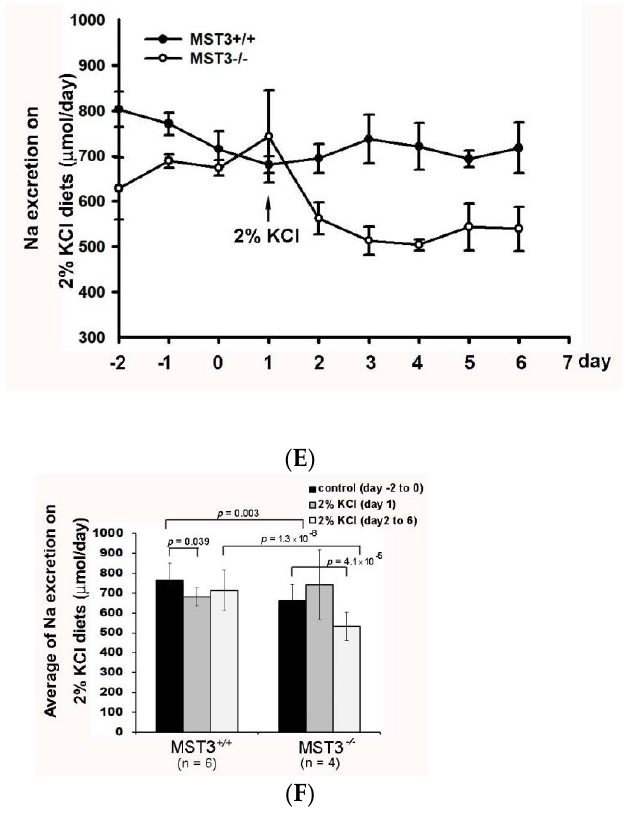
Figure 3. Reduction of diuresis, kaliuresis, and natriuresis in MST3 −/− mice fed 2% KCl diets. MST +/+ (●) and MST3 −/− ( ○ ) mice were fed a control diet for 3 days; then, the diet was changed to the 2% KCl diet for an additional 16 days. The urine volume ( A ), urinary K + ( C ), and urinary Na + ( E ) excretion were recorded over 9 days. The average group values were used to generate the graphs, and the error bars correspond to SE. The bar graphs ( B , D , F ) show the average of the data in ( A , C , E ) re- spectively.